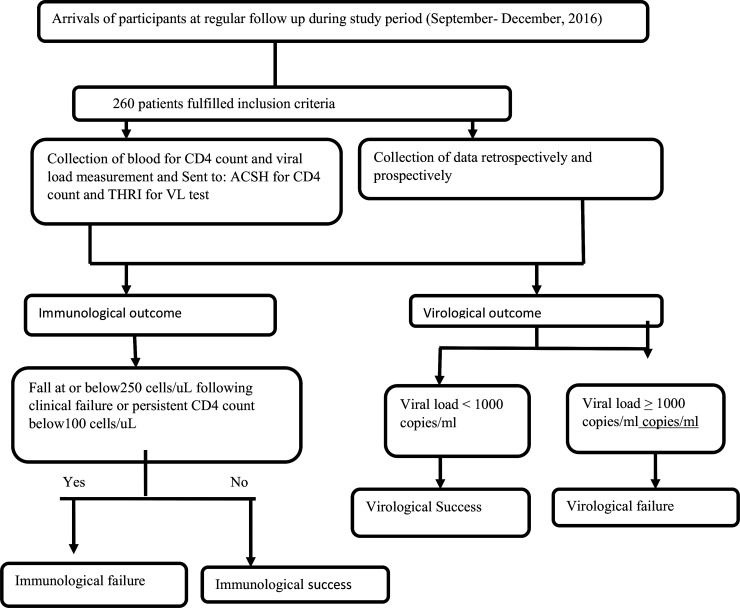
Work flow of the study.